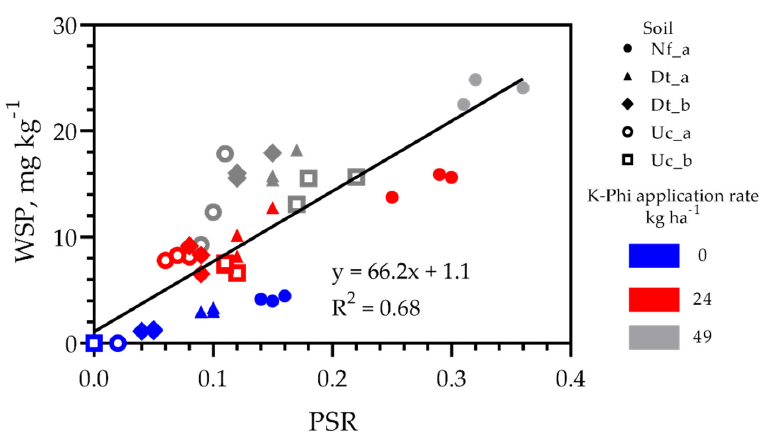
Figure 4. Relationship between the concentration of water-soluble phosphorus (WSP = Phi + Pi) and the phosphorus saturation ratio (PSR) for the five sandy soils of this study at three application rates of potassium